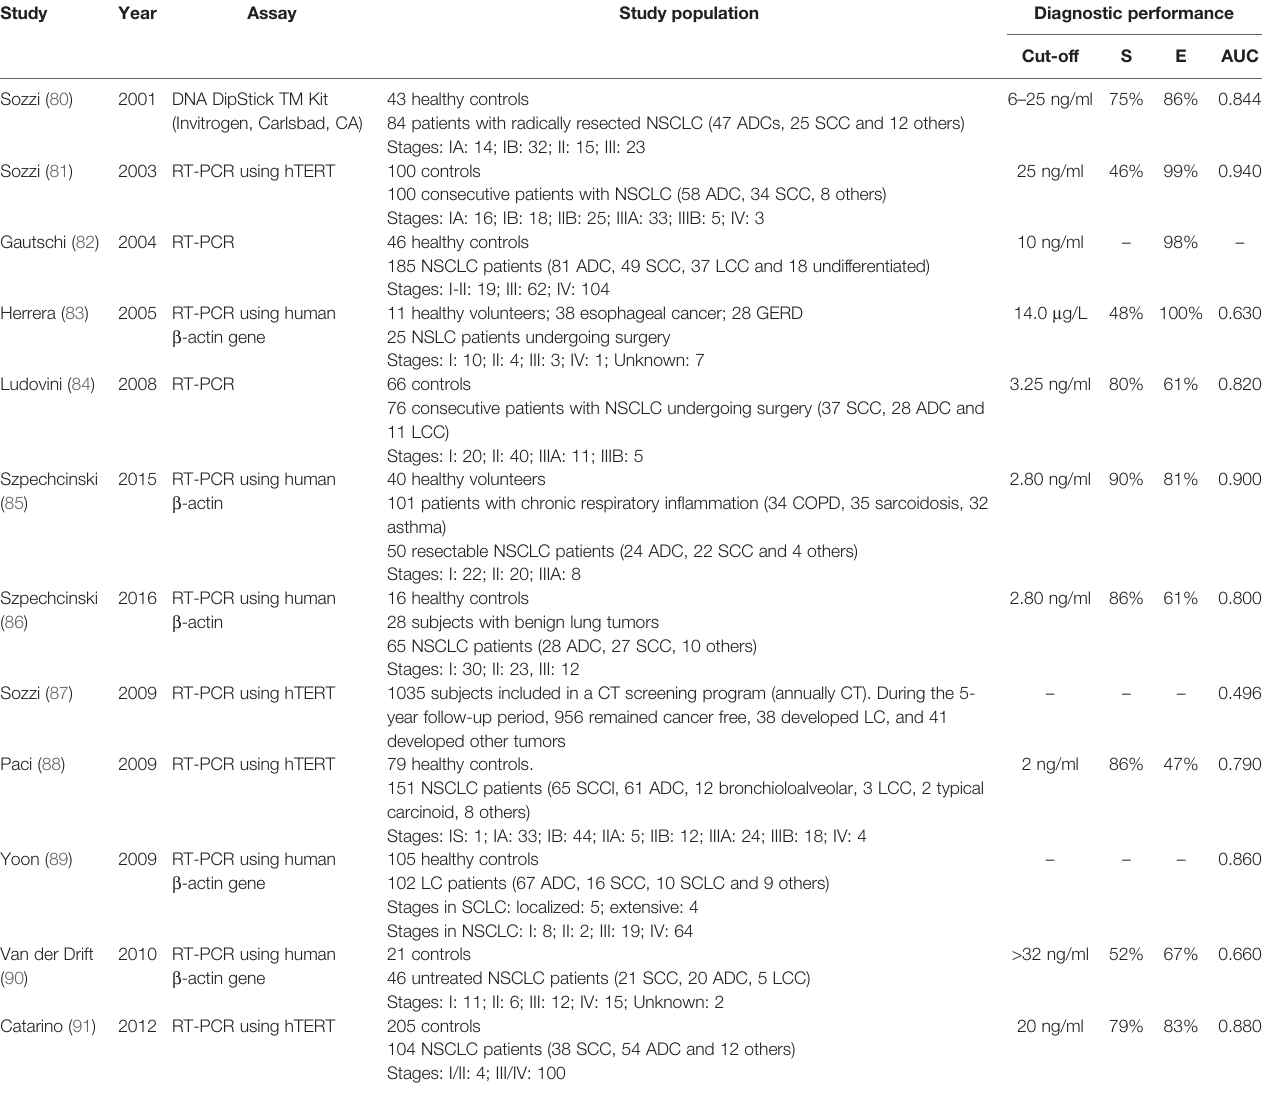
TABLE 2 | cfDNA plasma concentration performance as a biomarker for lung cancer